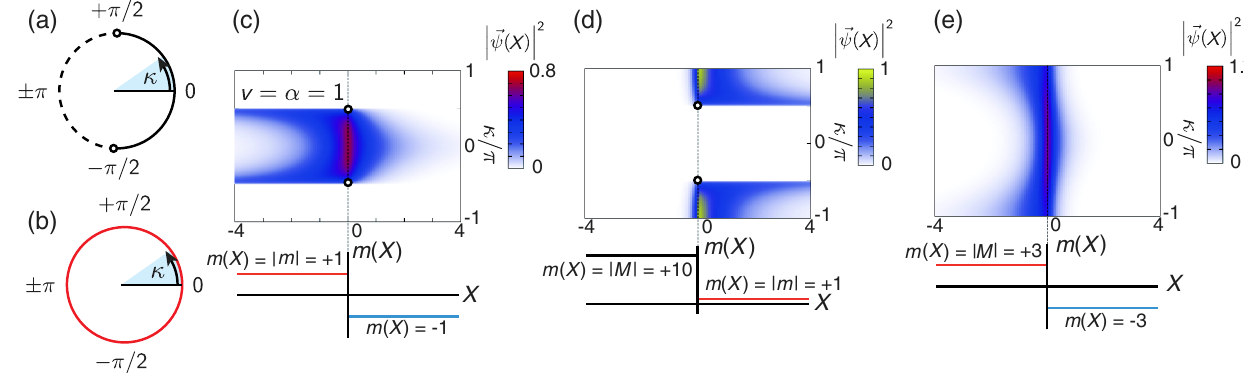
FIG. 5. Solutions for effective one-dimensional chiral Dirac equations (4). (a),(b) Simplified degrees of freedom κ corresponding to ; κ one parameter representation of loci of zero modes on ð κ . The solid (dashed) curve illustrates the loci of the domain-wall (surface) Y Z Þ zero modes. White circles indicate the Weyl points. (a) The case before the pair annihilation of the Weyl points, corresponding to (c) and (d). On the other hand, (b) after the pair annihilation corresponds to (e), where the surface loci are eaten up by the domain-wall loci, and the domain-wall loci form a closed Fermi surface in the Brillouin zone. (c) Wave-function amplitude for a domain-wall state for the chiral Dirac equation (4) with α in the plane of the real-space coordinate X and momentum coordinate κ , with v ¼ α ¼ 1 and þ þ m ð x Þ ¼ − θ ðþ X Þ þ θ ð − X Þ . The “ arc ” state at the domain wall penetrates into one side of the bulk at the Weyl points. Another degenerate “ arc" state localized in the other nearby side of the domain wall, obtained with v ¼ 1 and α − ¼ − 1 , penetrates to the other side of the bulk (not shown). (d) Wave-function amplitude for a surface state for the chiral Dirac equation (4), with v ¼ α ¼ 1 and m ð x Þ ¼ θ ðþ X Þ þ 10 θ ð − X Þ . The “ arc ” is formed in the missing part of the domain-wall arc. (e) Wave-function amplitude for a domain- wall state for the chiral Dirac equation (4), with v ¼ α ¼ 1 and m ð x Þ ¼ − 3 θ ðþ X Þ þ 3 θ ð − X Þ . The domain-wall state now forms the closed loop of the Fermi surface without penetration into the bulk. For j m ð X Þj > 2 , there are no zero modes for